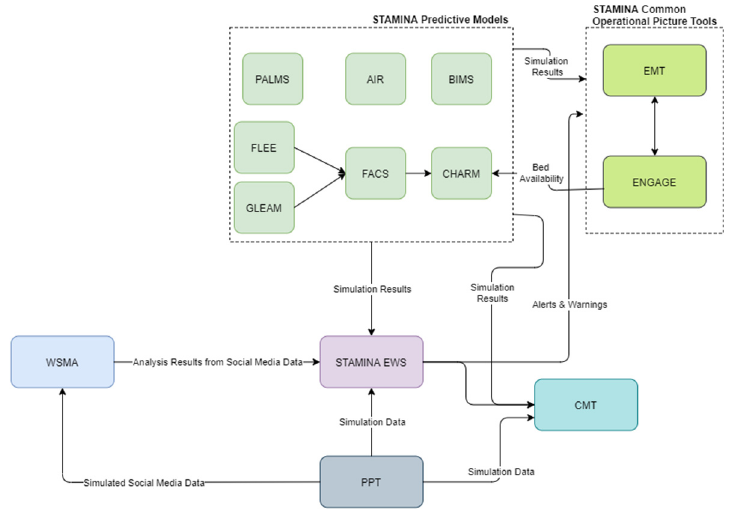
Figure 3. STAMINA preparedness phase and execution of a training exercise.